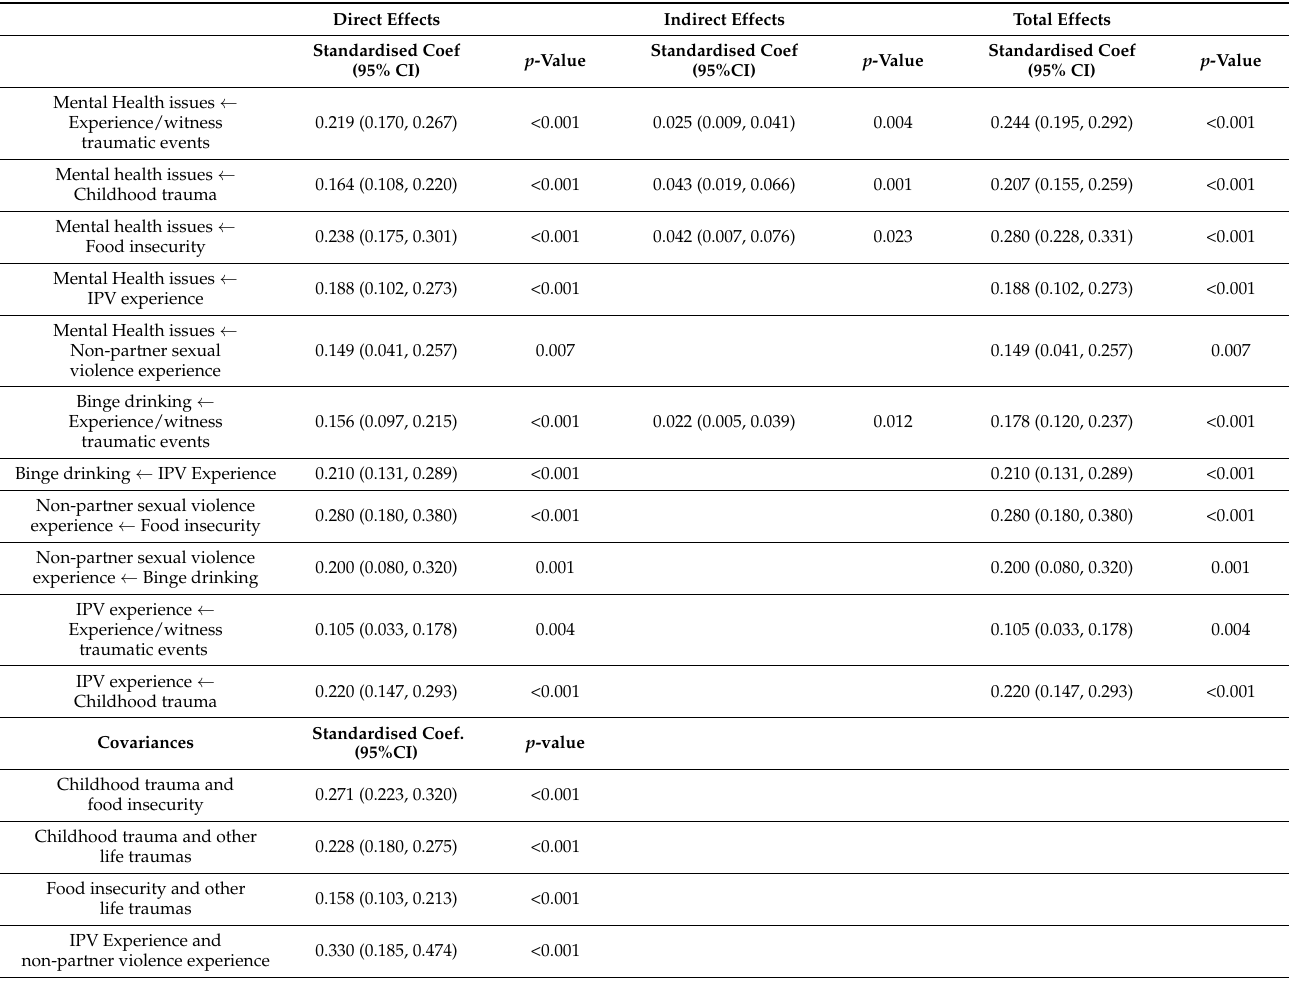
Figure 2. SEM final path model. Table 5. SEM Output Table.